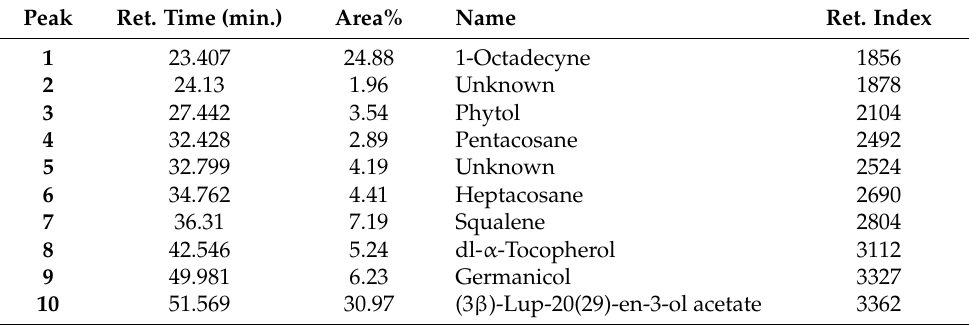
Table 1. Constituents of Sterculia diversifolia plant ethanolic extract as revealed by GC-MS. Peak Ret. Time (min.) Area% Name Ret. Index 1 23.407